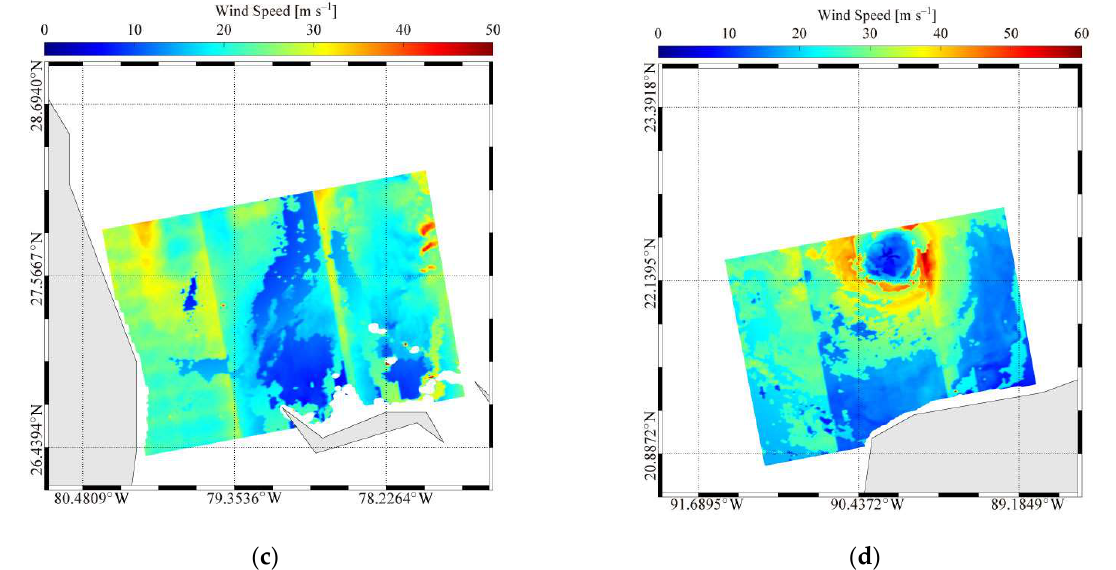
Figure 10. Maps of composite SAR-derived winds: ( a – d ) refer to the SAR scenes shown in Figure 1a–d.